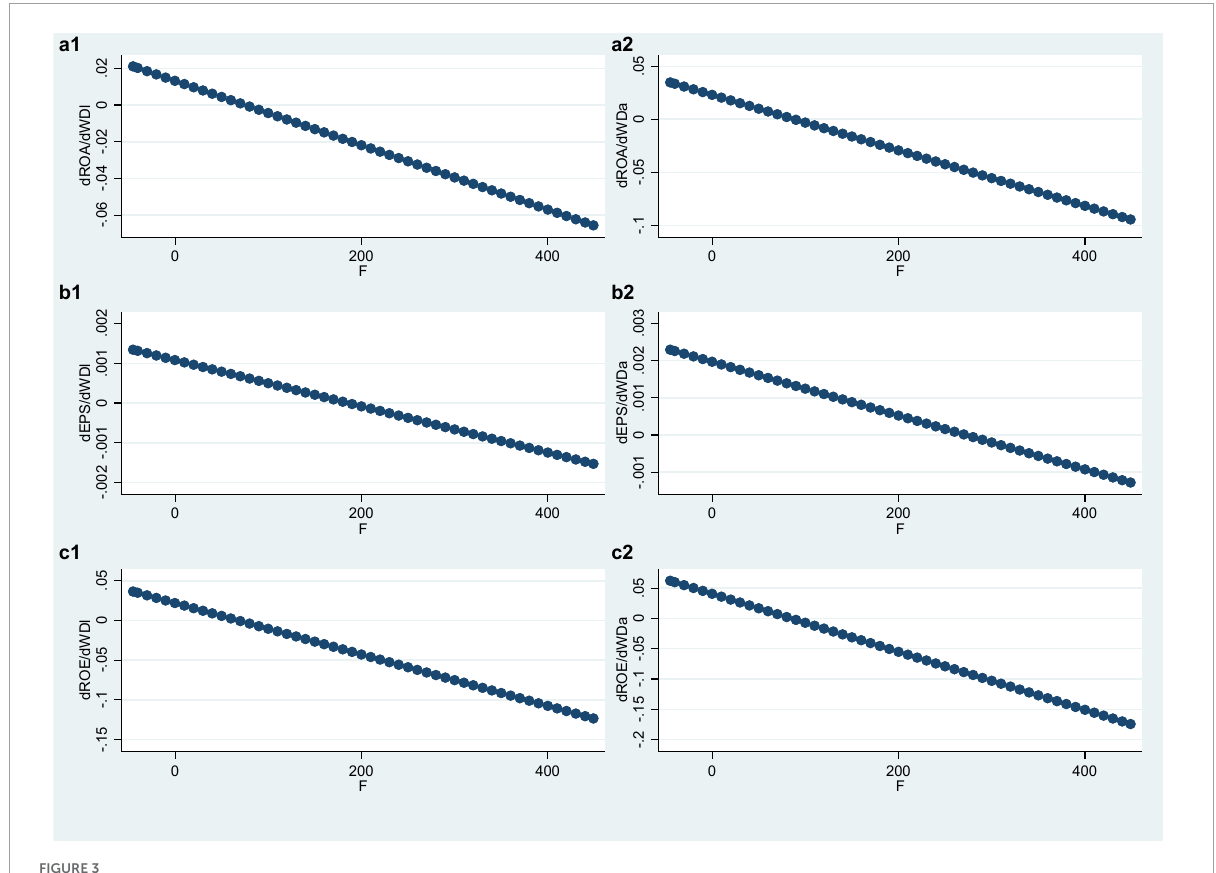
FIGURE3 Moderating effects of fairness preference. (a1–c2) Represent the relationship between different